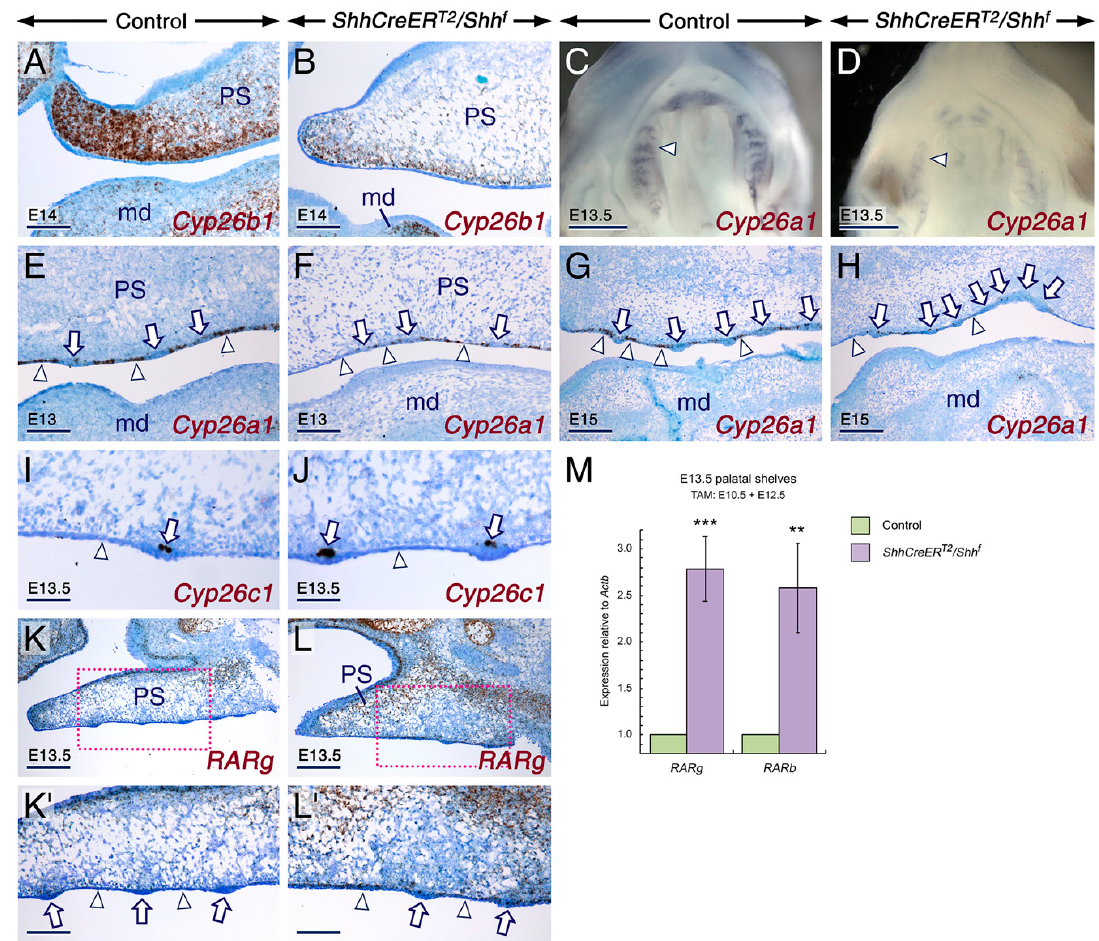
Figure 4. SHH signaling in the developing secondary palate is required for expression of Cyp26a1 and Cyp26b1 to prevent enhancement of retinoic acid signaling. ( A – L ) Representative developing palates from control and ShhCreER T2 / Shh f mutant embryos first exposed to tamoxifen (TAM) at E10-5-E11. The developmental stages are indicated on the panels. Whole-mount in situ hybridization (WMISH) with Dig-labelled riboprobes ( C , D ) and in situ hybridization in parasagittal sections (anterior palatal region towards the left of the panels) with oligonucleotide probes ( A , B , E – L ). The inter-rugal epithelium and rugae palatinae are indicated by arrowheads and arrows, respectively. ( A , B ) Cyp26b1 expression in sections of palates (see also Figure S4) from control ( A , n = 2) and mutant ( B ; n = 2) embryos. The mutant palate shows decreased Cyp26b1 hybridization signals (brown) as compared to the control palate. ( C – H ) The mutant palates ( D , F , H ; n = 3 for WMISH and n = 4 for ISH in sections) show decreased Cyp26a1 hybridization signals (dark purple in whole-mounts and black in sections) as compared to control palates ( C , E , G ; n = 3 for WMISH and n = 4 for ISH in sections). In control palates Cyp26a1 transcripts are enriched in the inter-rugal epithelium. ( I , J ) Cyp26c1 (black) is expressed in subsets of cells within the basal layer of rugae palatinae (arrows in I and J ) in control ( I ; n = 2) and mutant ( J ; n = 2) palates. (K,L) The mutant palate ( L ; n = 3) shows increased RARg hybridization signals (brown) in the mesenchyme and inter-rugal epithelium as compared to the control palate ( K ; n = 3). K’ and L’ are magnified views of the boxed areas in K and L , respectively. ( M ) RT-qPCR assay for RARb and RARg relative to Actb ( β -actin) in paired palatal shelves from E13.5 controls ( n = 7) and ShhCreER T2 / Shh f mutants ( n = 7) first exposed to TAM at E10.5 showing upregulation of RARb ( p = 0.004) and RARg ( p = 0.000) in the mutant palatal shelves as compared to the control palatal shelves. Data are mean values ± standard deviation; **: p < 0.01; ***: p < 0.001. md, mandible; PS, palatal shelf. Scale bars: 500 µ m ( C , D ), 200 µ m ( K , L ), 100 µ m ( A , B , E – H , K’ , L’ ) and 50 µ m ( I , J